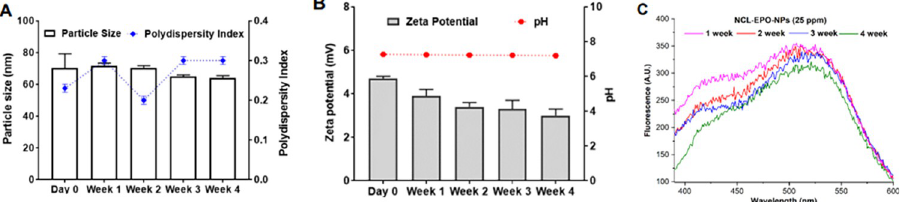
Fig 4. P407-stabilized NCL-EPO-NPs with NCL loading of 40% w/w of EPO show physical and chemical stability for 4 weeks. Three different batches of NCL-EPO-NPs were prepared, and their physical and chemical stability was evaluated for 4 weeks. (A) Particle size and polydispersity index of NCL-EPO-NPs over a period of 4 weeks showed negligible changes. Data expressed as mean ± SD ( n = 3). (B) Zeta potential and pH of NCL-EPO-NPs did not show any appreciable changes after 4 weeks of storage. Data expressed as mean ± SD ( n = 3). (C) The fluorescence intensity of NCL-EPO-NPs (NCL concentration: 25 ppm) showed negligible changes for 4 weeks indicating chemical stability. Analysis was carried out in triplicate and representative fluorescence spectra are shown in the figure. Raw data are found in the file S1 Data. NCL, niclosamide; NCL-EPO-NP, NCL-loaded EPO